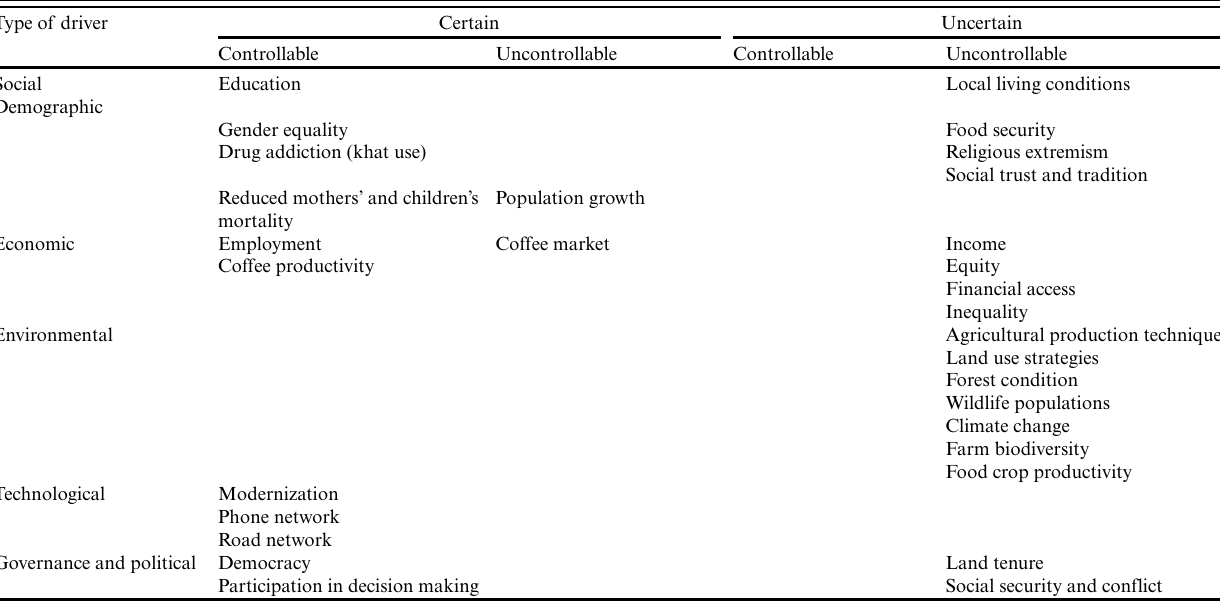
Table 1 . Drivers of change in the study landscape as reported by local